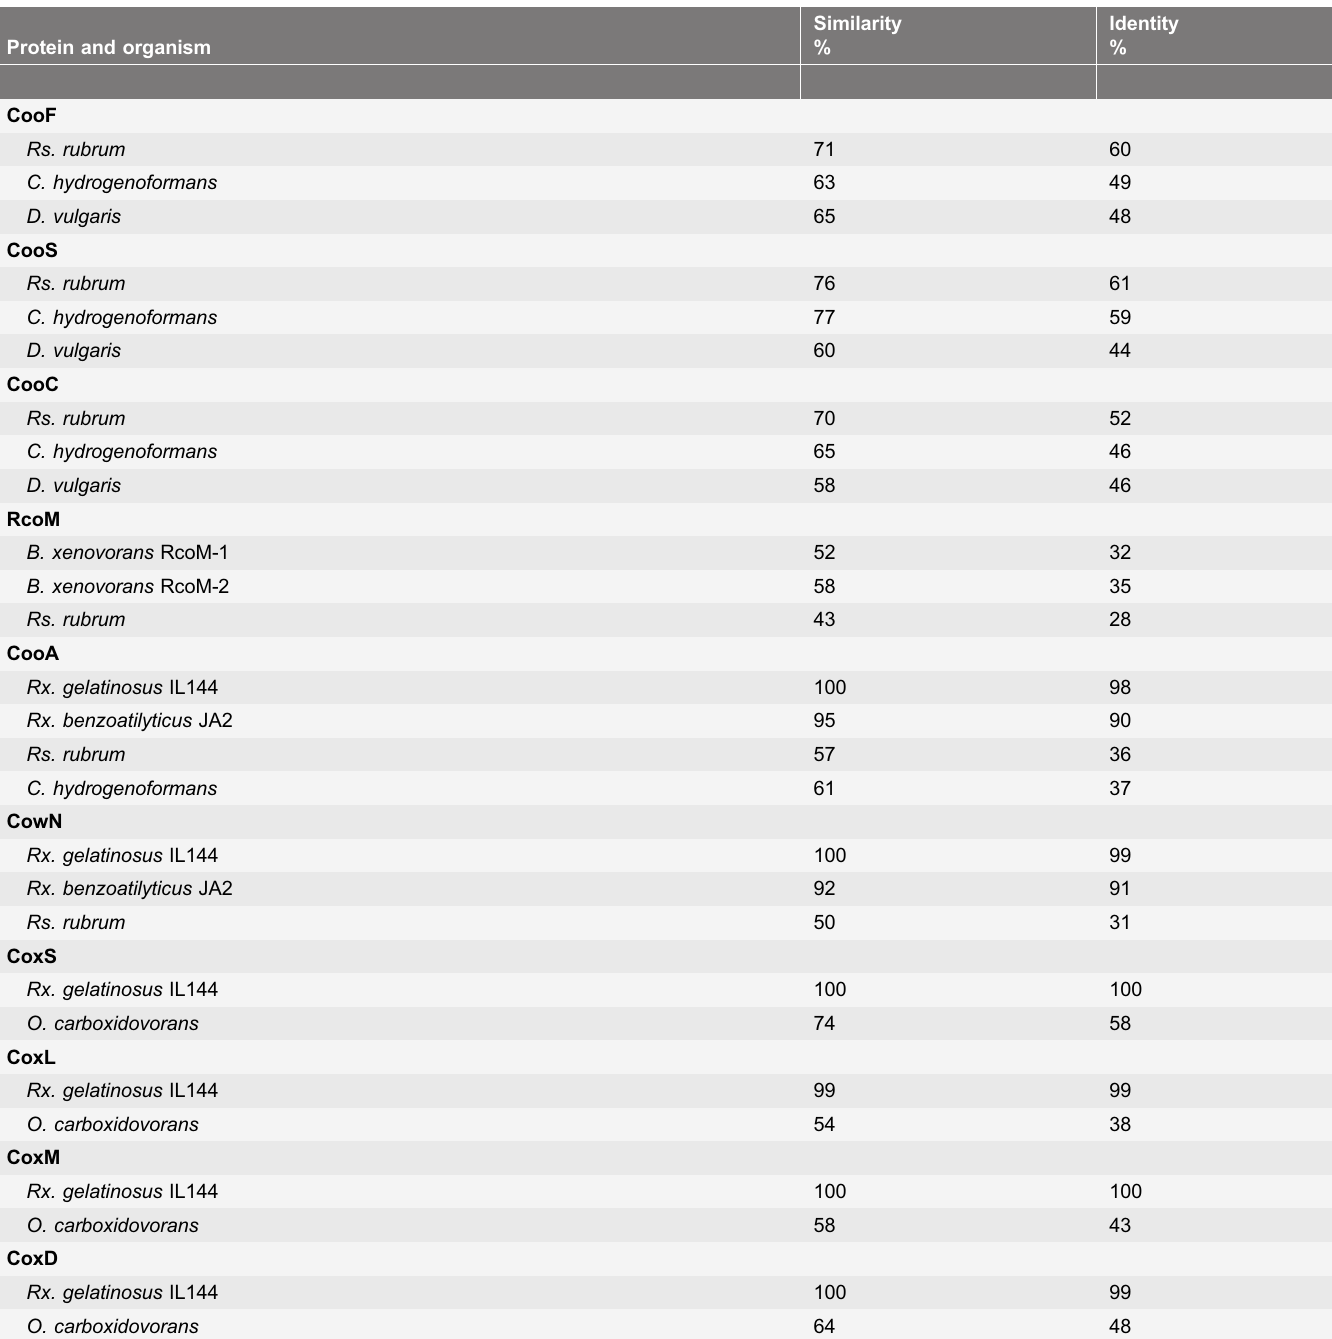
Table 1. Similarity and identity of select CO dehydrogenase proteins and CO-responsive transcription factors between Rubrivivax gelatinosus CBS with other bacterial species, generated by EMBOSS 6.3.1: matcher search [62]. Protein and